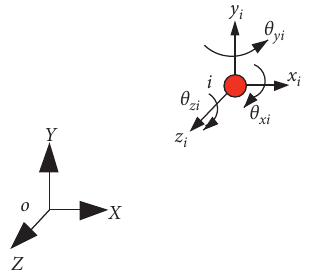
Figure 4: Lumped mass element for the disc.